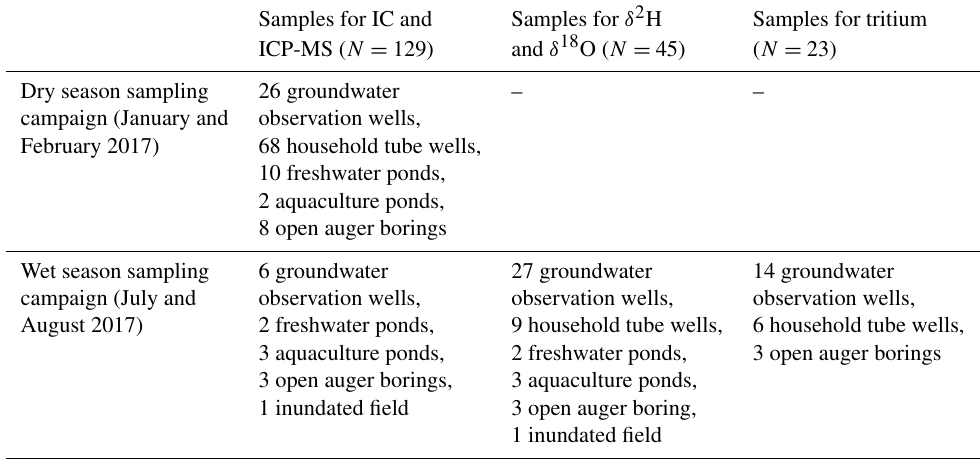
Table 1. Overview of chemical and isotope samplings.